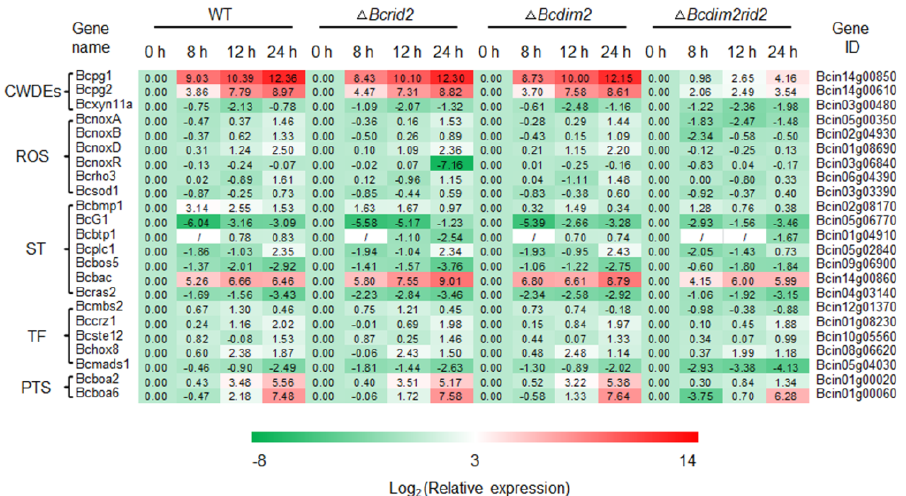
Figure 7. The pathogenic genes are suppressed during the interaction between ∆ Bcdim2rid2 and host. CWDE: cell wall degrading enzyme gene; ROS: ROS metabolism related gene; ST: signal transduction component; TF: transcriptional factor; PTS: phytotoxin synthesis gene.